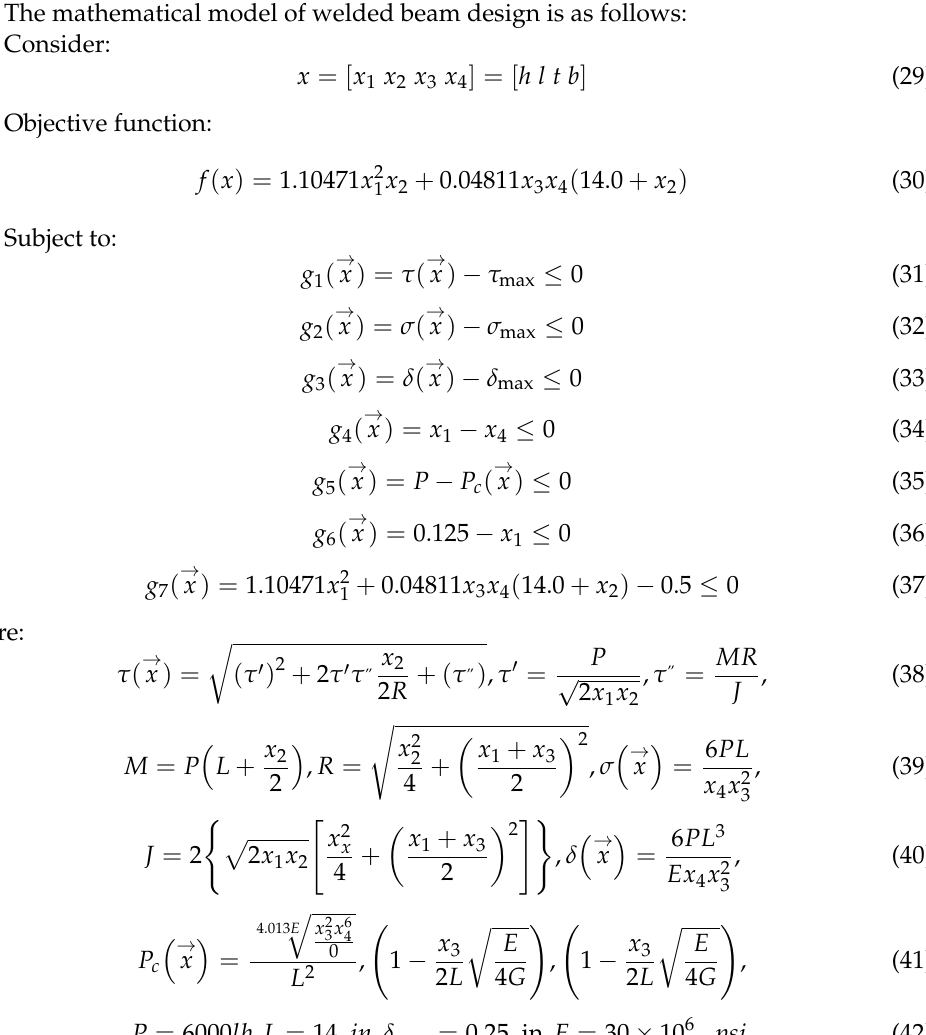
Figure 11. Model of welded beams design.